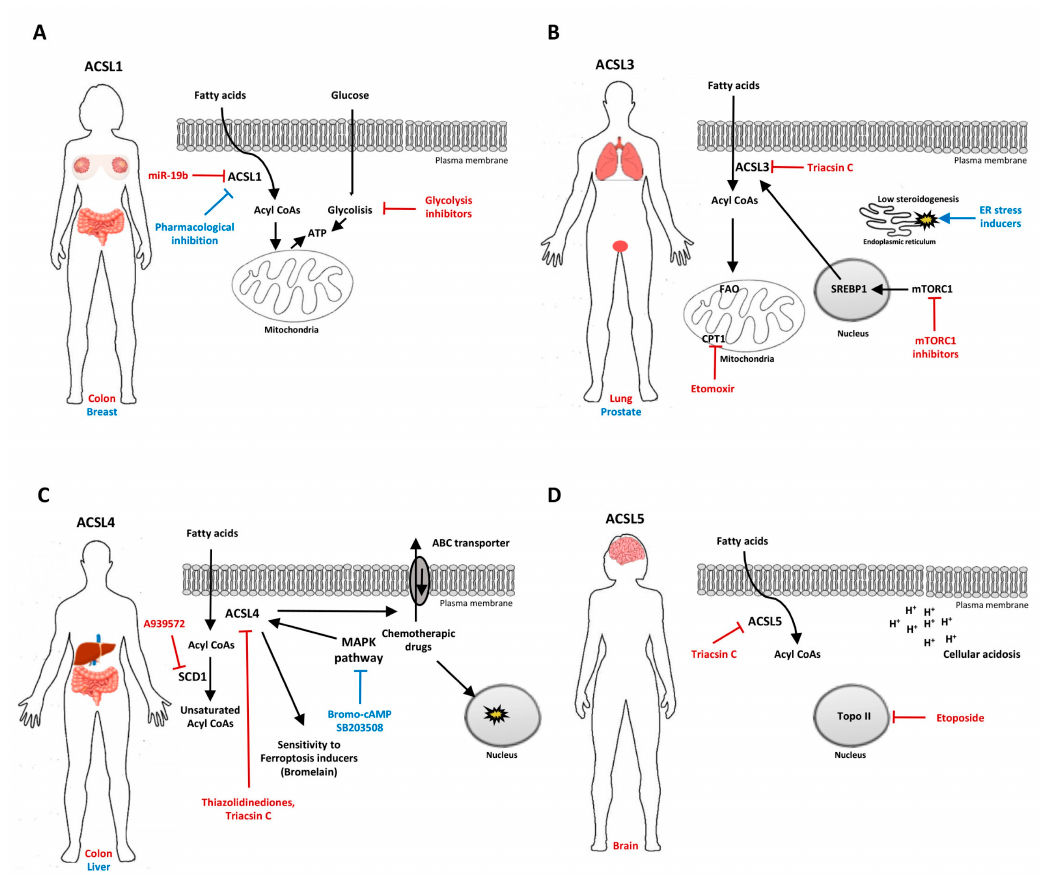
Figure 1. Proposed targeting approaches involving ACSL isoenzymes in cancer. ( A ) ACSL1 and glycolytic pathway co-targeting in colon cancer (red), and ACSL1 single targeting breast cancer (blue). ( B ) ACSL3, CPT1 and the mammalian target of rapamycin complex 1 (mTORC1) co-targeting in lung cancer (red) and the combination of ACSL3 inhibition with ER stress inducers in lung and prostate cancer. ( C ) Combined ACSL4 and SCD1 inhibition in colon cancer (red) and ACSL4 indirect targeting via the p38 MAPK pathway inhibition in liver cancer (blue). ( D ) ACSL5 and Topoisomerase II (Topo II) co-targeting with a potential therapeutic benefit in glioma.